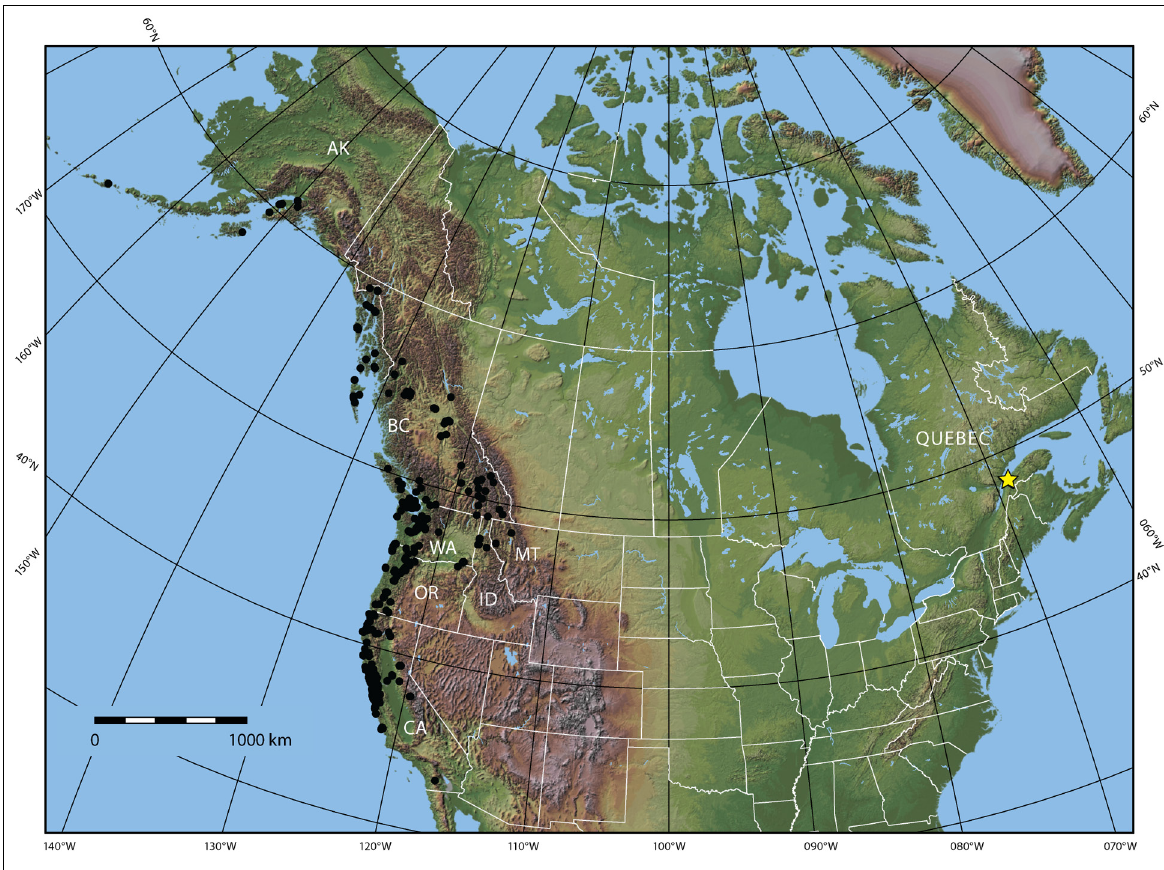
Figure 1. Distribution of Prophysaon andersonii . New record (yellow star) from Quebec (Anse à Wilson, Parc national du Bic Québec, municipalité régionale de comté du Rimouski-Neigette; 48.3597°N, 068.7983°W) and occurrence records (black circles) within the native range based on data from GBIF (2019), Pearce and Richart (2010), Smith et al. (2018), and Appendix. Abbreviations (Canada): BC = British Columbia; (USA) AK = Alaska; CA = California; ID = Idaho; MT = Montana; OR = Oregon; WA = Washington.